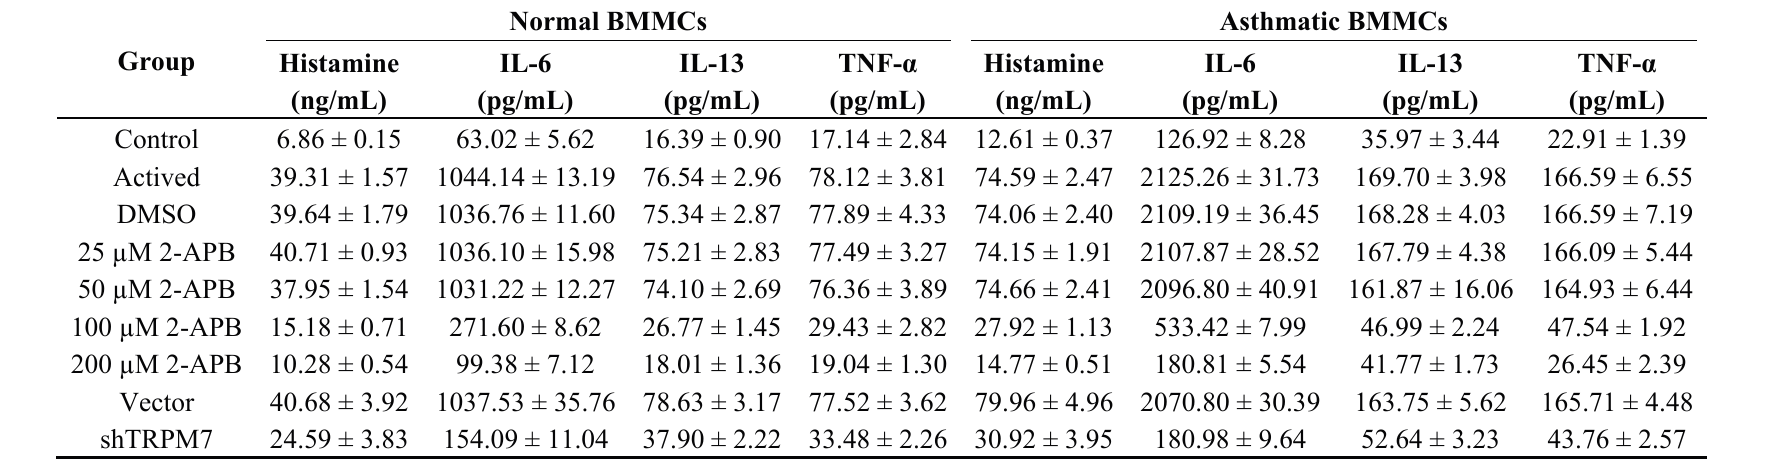
Table 2. Levels of cytokines secretion in rat